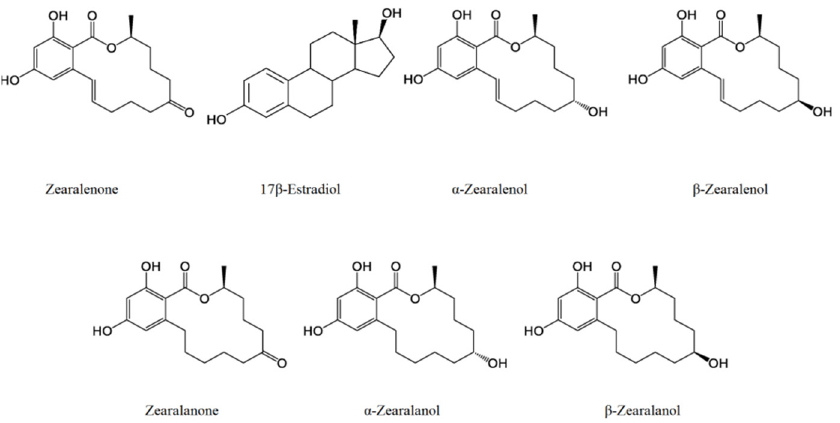
Figure 1. Chemical structure of zearalenone and its main metabolites and their structural similarity to 17 β -estradiol.